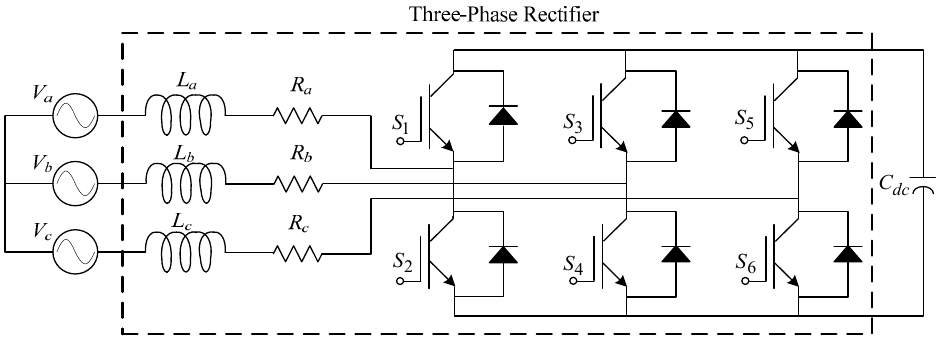
Figure 10. Future work with a three ‐ phase rectifier integrated into the proposed full ‐ bridge inverter.